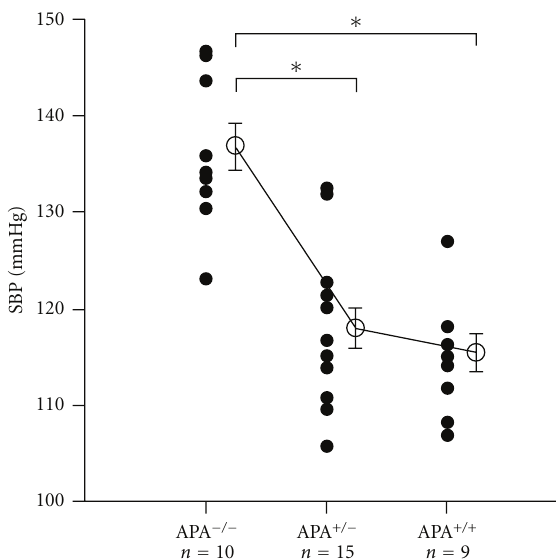
Figure 1: E ff ects of APA deficiency on SBP. Systolic blood pressure (SBP) of APA − / − , APA + / − , and APA + / + mice at 3 months ( n = 9 to 15 per group) was determined by a tail-cu ff system. Each datum point represents the mean measurement of 2-d taken after 4-d training period. The average ± SEM of each group is represented by an open circle and a bar. ∗ P < .